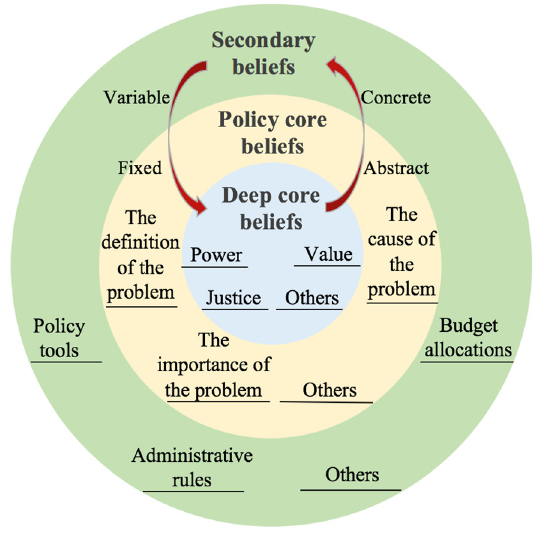
Figure 2. Structure of policy belief systems, adapted from Sabatier [35].